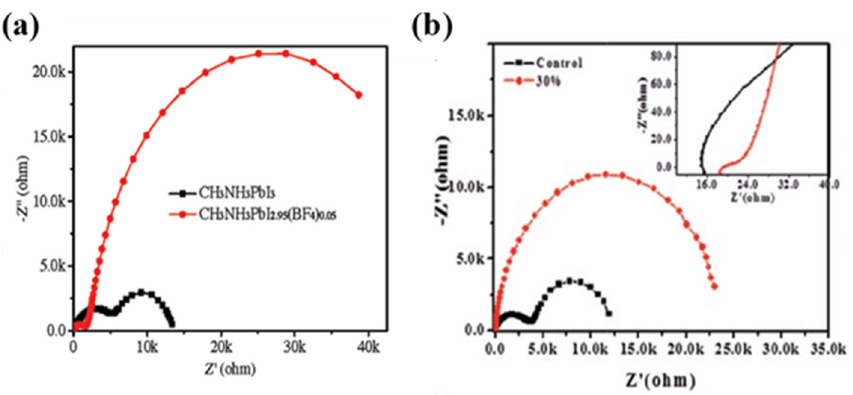
Figure 12. Nyquist plots of carbon counter electrode-based HTM-free PSCs: ( a ) with single anion and mixed anion perovskite, measured in the dark at a bias of 0.6 V (Reproduced with permission from [32]. Wiley-VCH Verlag GmbH & Co. KGaA Weinheim, 2015.); and ( b ) with perovskite incorporated with 30% LiCl and without it, measured in the dark at a bias of 0.6 V (Reproduced with permission from [41]. Royal Society of Chemistry, 2016.).